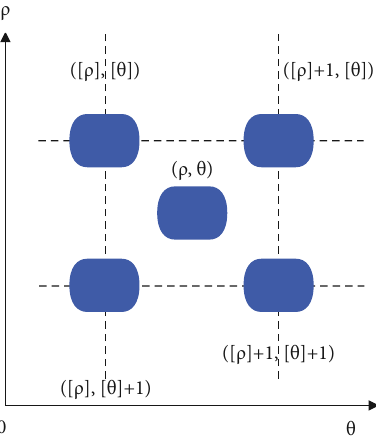
Figure 2: Schematic diagram of bilinear interpolation.